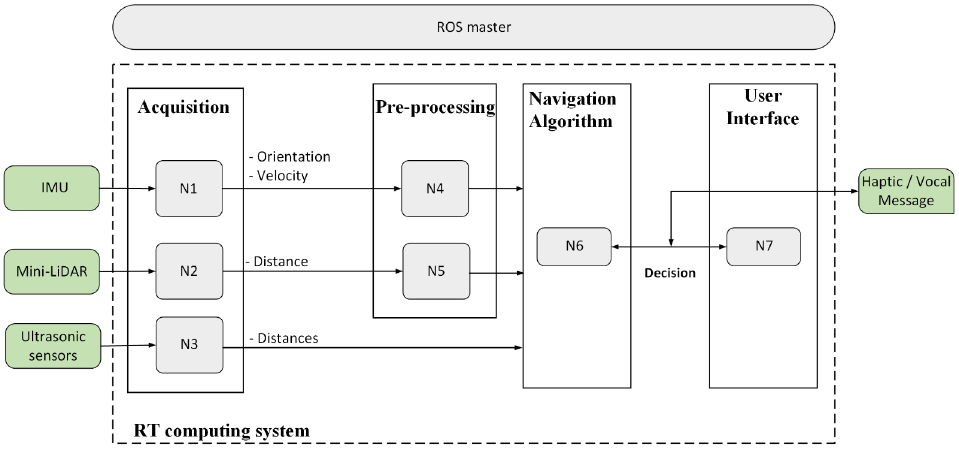
Figure 2. High level architecture for the navigation